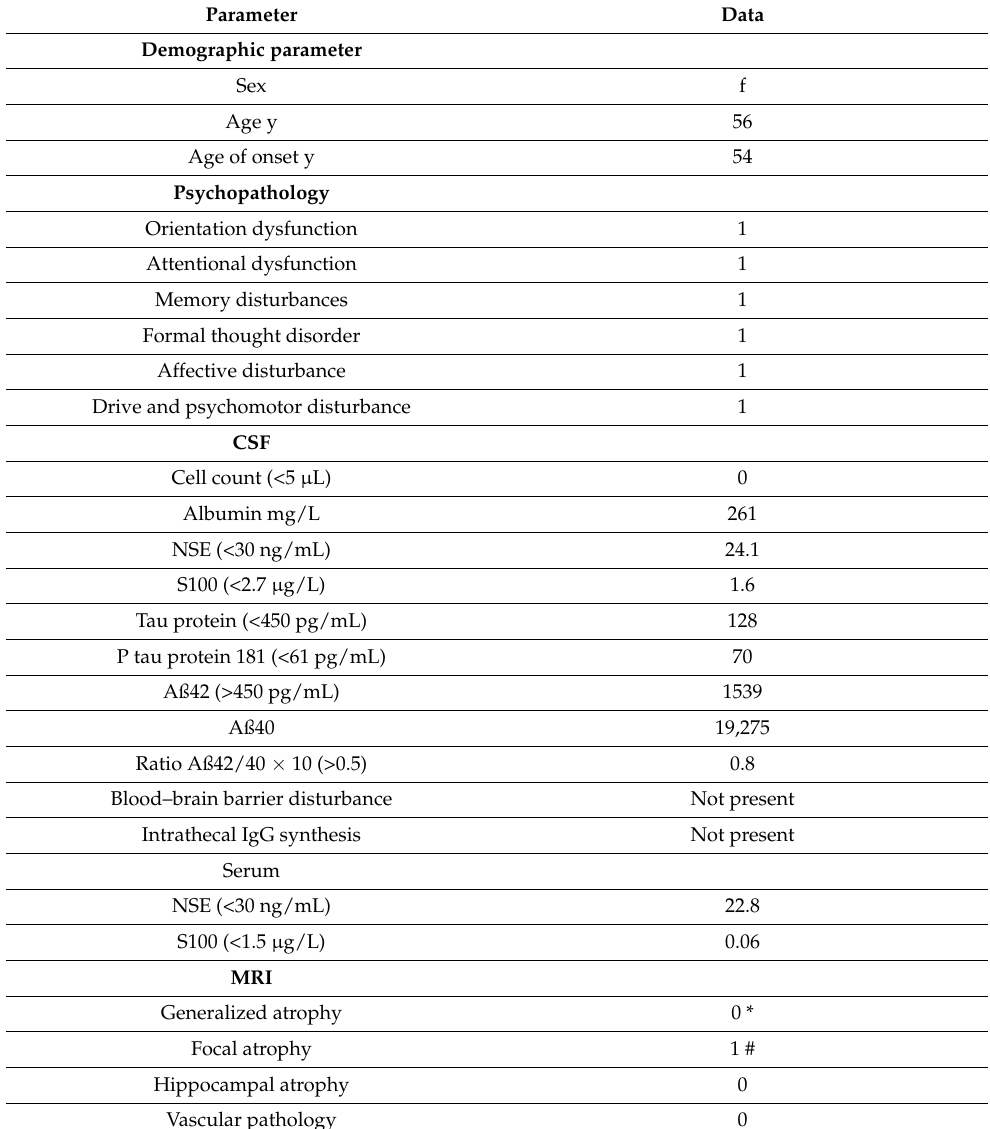
Table 2. Clinical and laboratory characteristics of